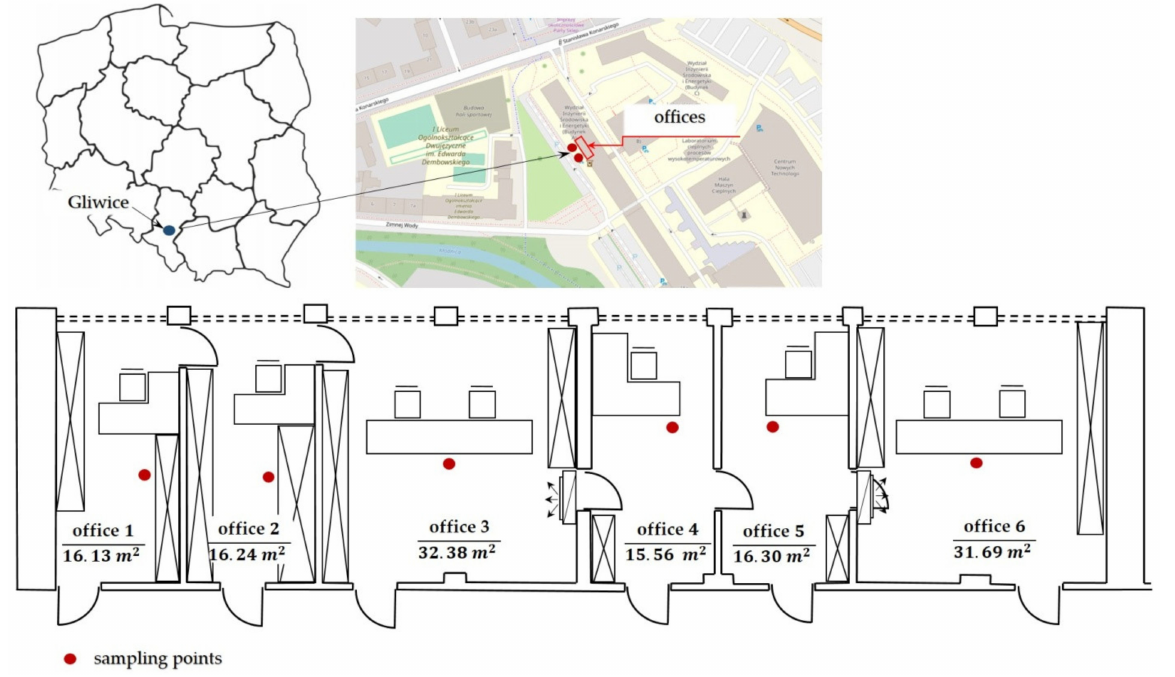
Figure 1. Location and plan of offices with outdoor (shown on the map) and indoor sampling